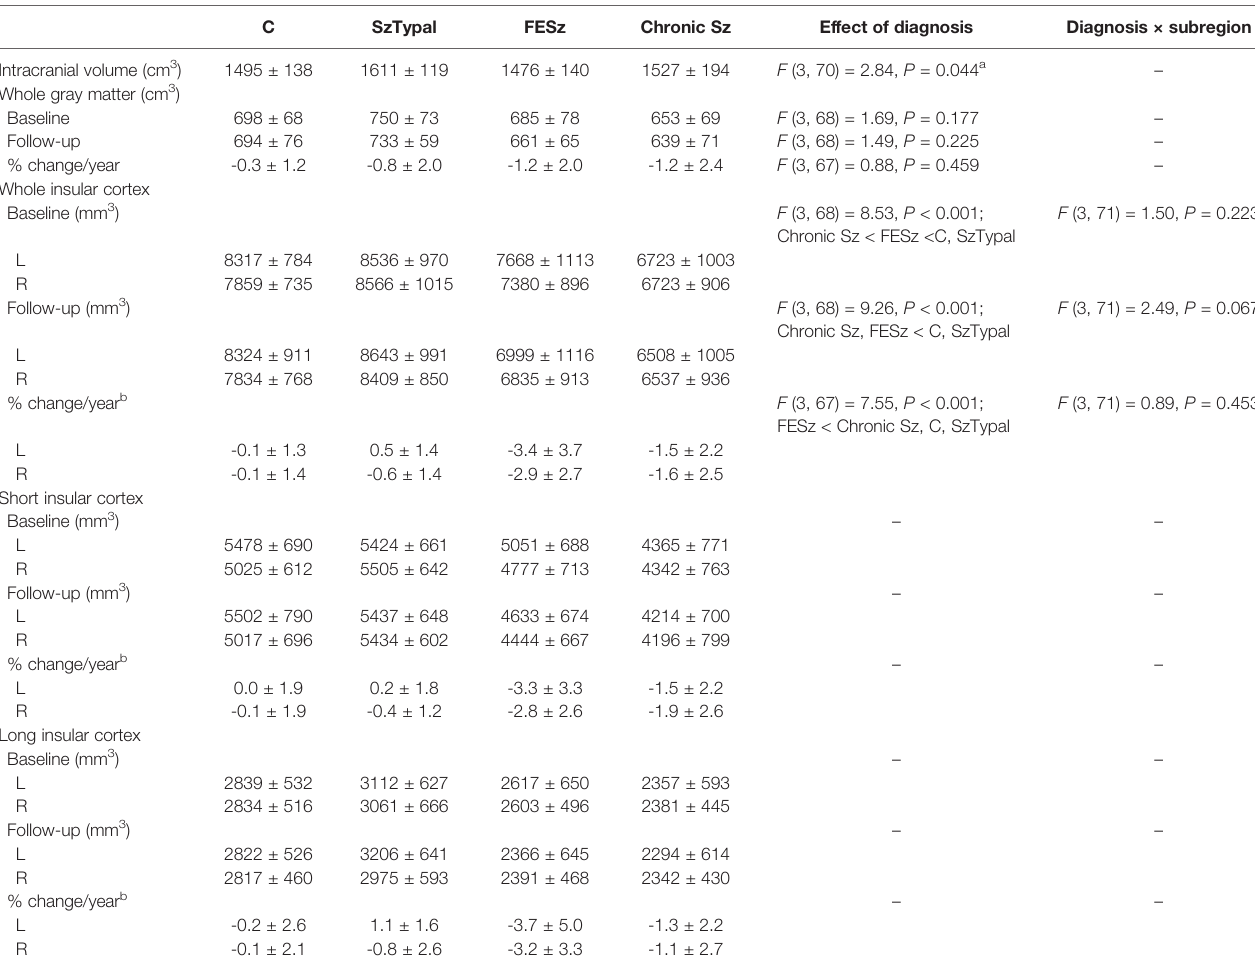
TABLE 2 | Brain measurements of study